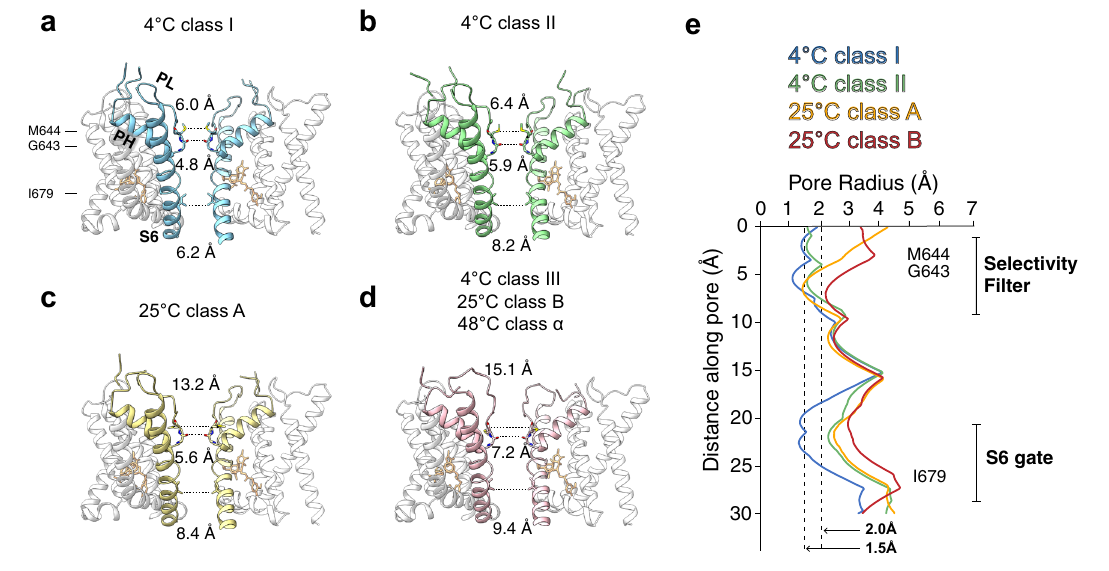
Fig. 2 Permeation pathway analysis of the pore domains of TRPV1 4°C,classI , TRPV1 4°C,classII , TRPV1 25°C,classA , TRPV1 4°C,classIII , TRPV1 25°C,classB , and TRPV1 48°C,class α . a – d Only two subunits are shown for clarity, with S6 helix (S6), pore loop (PL) and pore helix (PH) as indicated. Diagonal distances at the two narrowest restriction points are shown. e Pore radii calculated using the HOLE program for representative TRPV1 structures as color-coded. The radius of water is 1.5 Å, while 2.0 Å is considered the minimal radius for a hydrophobic gate to be open. Residues corresponding to the SF (M644 and G643) and the S6 gate (I679) are